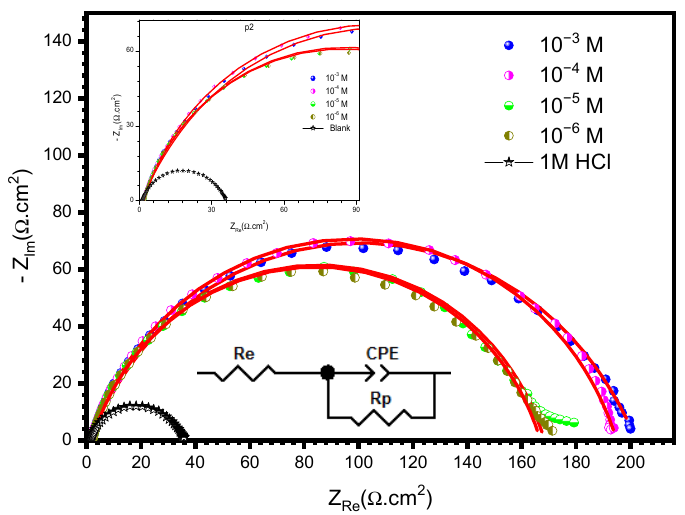
Figure 4. Nyquist curves for MS plunged in 1 M HCl medium, both unprotected and protected by varying concentrations of TGP. Table 2. EIS parameters for MS plunged in 1M HCl solution, both unprotected and protected by varying concentrations of TGP.